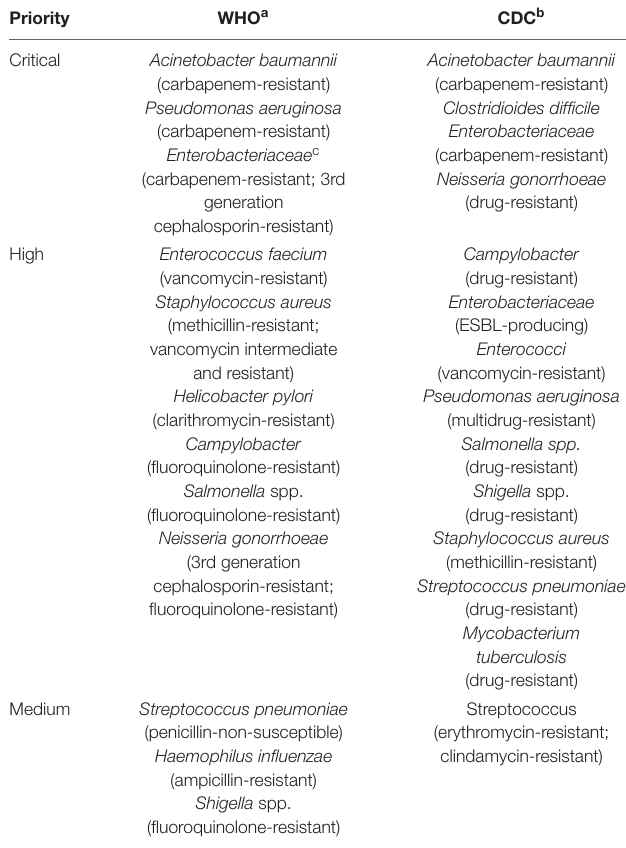
TABLE 1 | WHO and CDC priority bacteria list for